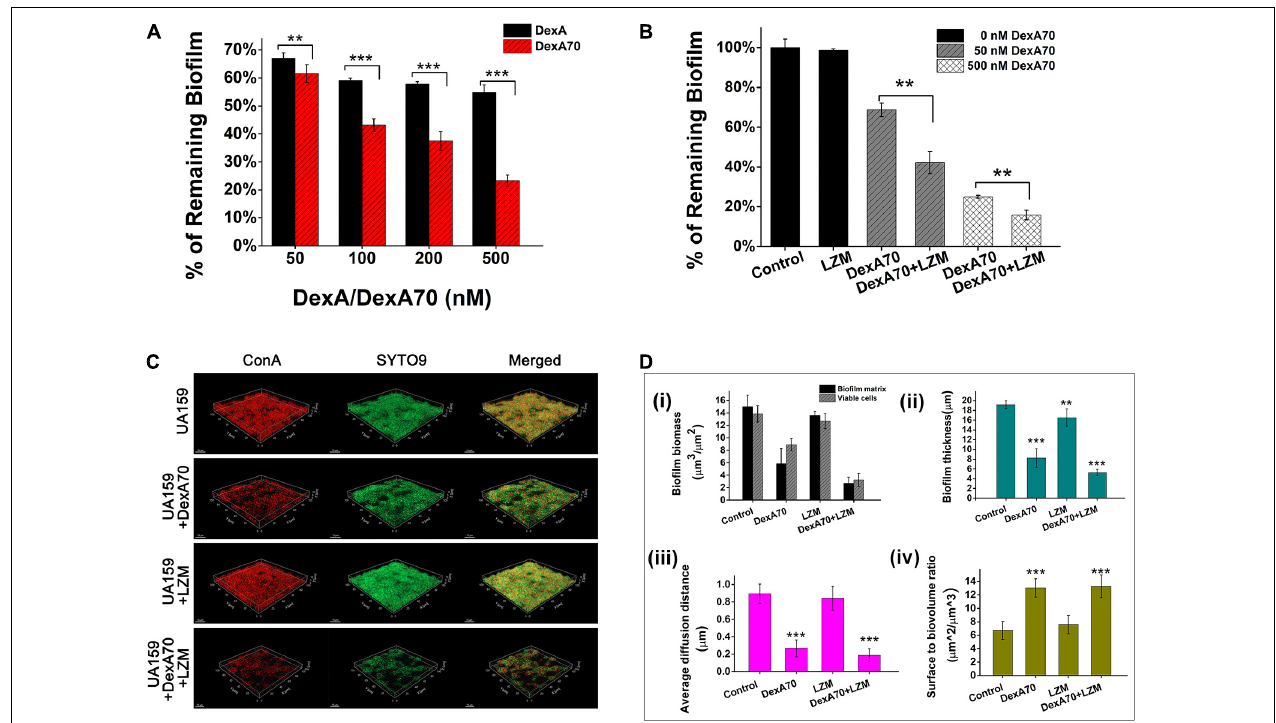
FIGURE 4 | Synergistic effect of DexA70 and lysozyme (LZM) on biofilm treatment. (A) The comparison between DexA and DexA70 in biofilm dispersion. Enzymes were added at 50, 100, 200, and 500 nM; the activity of DexA70 is much higher than DexA. Means ± SD are shown. (B) DexA70 disassembled 12 h biofilm in a dose-dependent manner with or without 2 mg/ml lysozyme. Means ± SD are shown. (C) The three-dimensional CLSM images for 12 h Streptococcus mutans biofilm treated with/without DexA70 and lysozyme (stained in red by ConA and green by SYTO9). (D) Quantitative analysis of biofilm structure in different conditions containing the biomass, mean thickness, thickness distribution, and surface-to-volume ratio. (i). Biofilm biomass and viable cell biomass. (ii). biofilm thickness. (iii). Average diffusion distance of biofilm. (iv). Surface to biovolume ratio of biofilm. Data were calculated from three independent measurements and were reported as average. Student’s t -test was used to conduct statistical analyses, and differences were considered significant when * p < 0.05. ** p < 0.01; *** p <